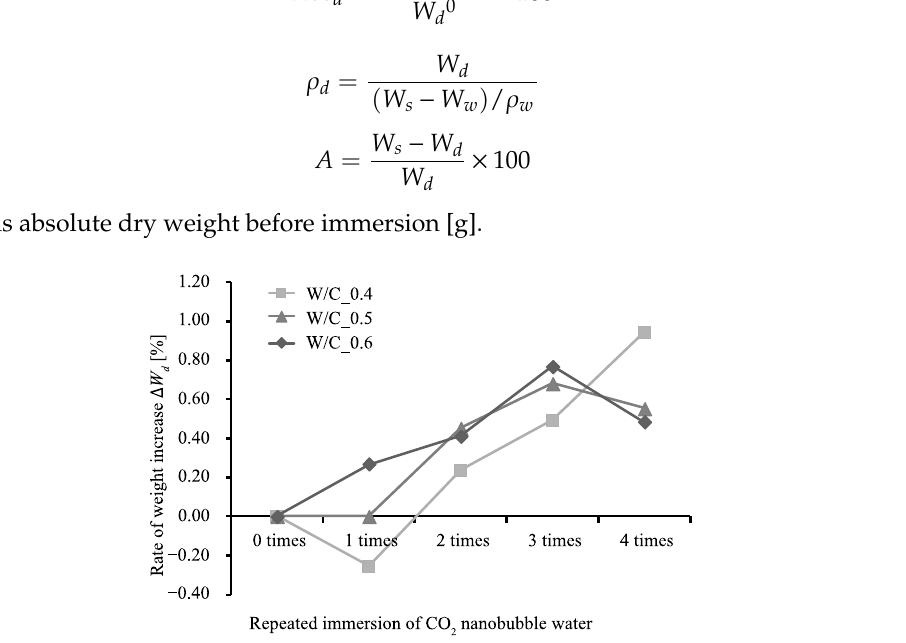
Figure 2. Relationship between number of immersions and rate of specimen weight increase.